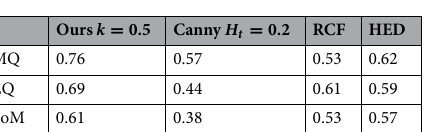
Figure 14. ( a ) Input image obscured by rains. ( b ) GT (contours perceived by human). ( c ) Gaussian prefilter, (MQ, EQ, FoM) = (0.67, 0.60, 0.60). ( d ) our method, (MQ, EQ, FoM) = (0.69, 0.89, 0.53). ( e ) RCF, (MQ, EQ, FoM) = (0.60, 0.50, 0.50). ( f ) HED, (MQ, EQ, FoM) = (0.49, 0.48, 0.48).